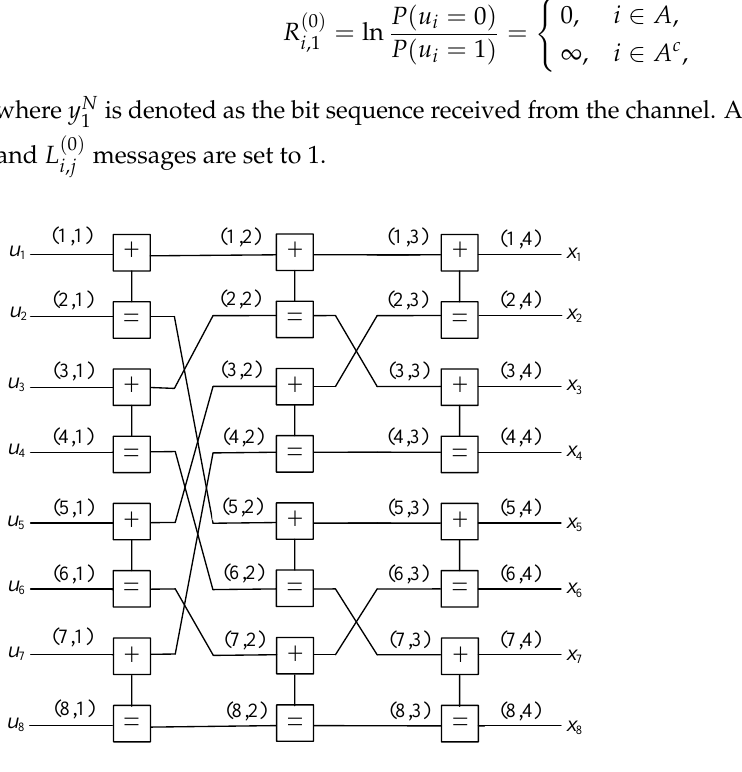
Figure 1. The factor graph of the generation matrix G 8 = B 8 F ⊗ 3